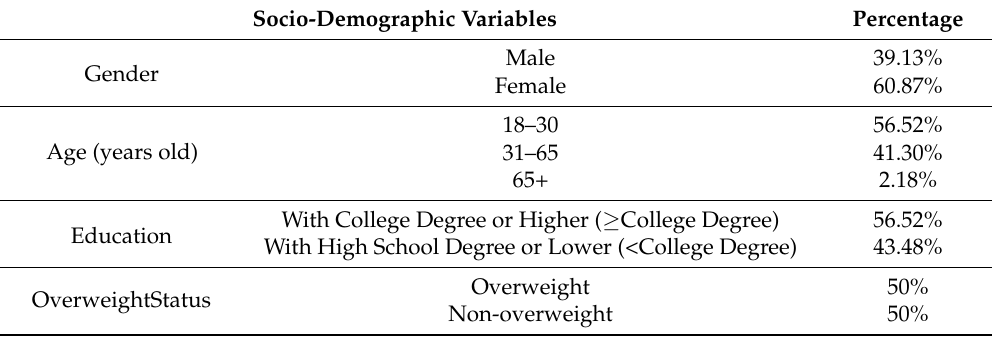
Table 1. The socio-demographic characteristics of the participants in this